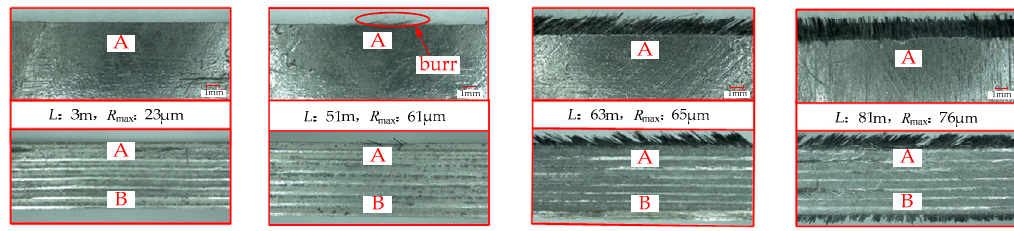
Figure 8. Burr formation on the machined workpiece surface: A-upper surface B-lower surface.